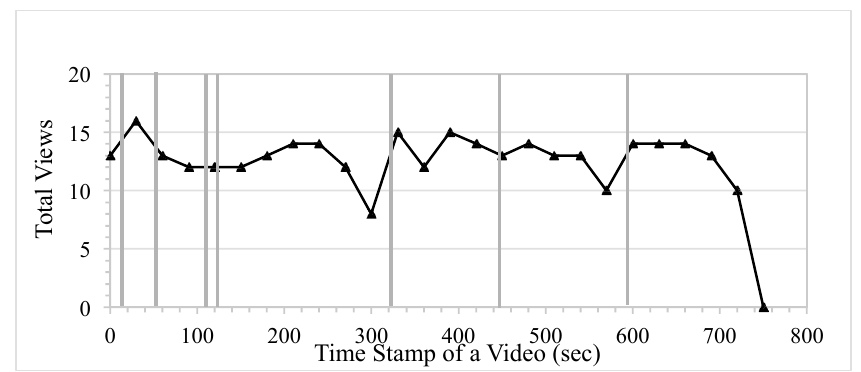
Fig. 5. Total Views vs. time plot for Lecture 10 (Torsional Shear Stress & Strain Lecture). The grey vertical lines indicate when a slide changed.